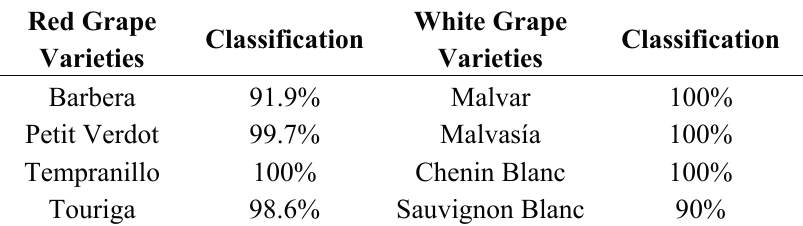
Table 4. Classification by a PNN for samples collected in 2012.